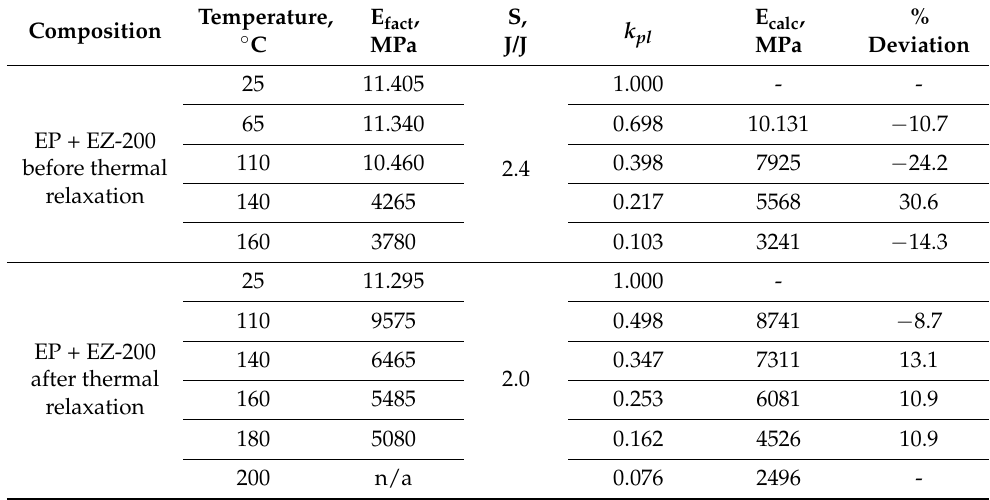
Table 3. Comparative actual and calculated data of the modulus of elasticity of fiberglass plastics on epoxy resin and fiberglass fabric EZ-200 at heating before and after thermal relaxation.